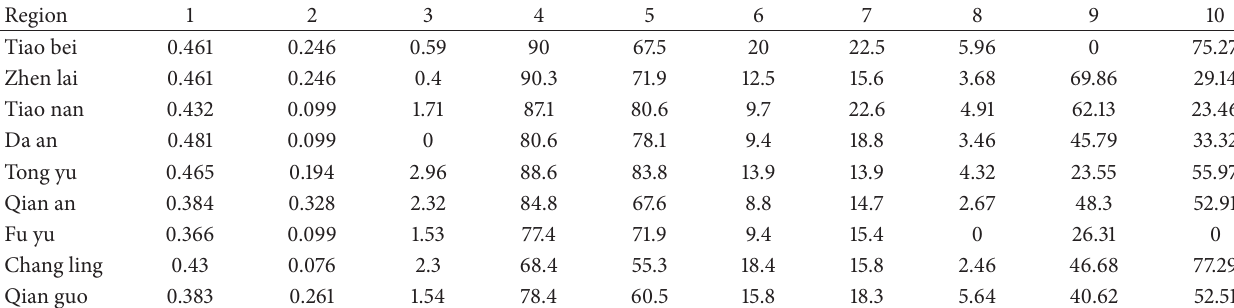
Table 1: Original data of each region.